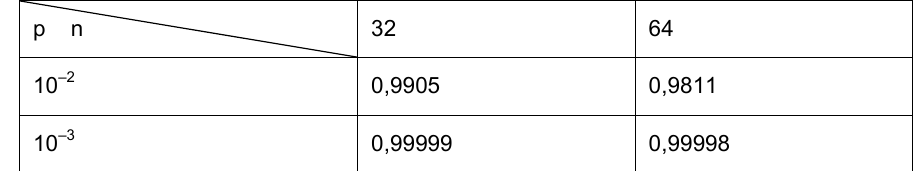
U tabeli 1 date su vrednosti Psk za parametre iz prethodnog prime- ra, ali za slu č aj trostrukog